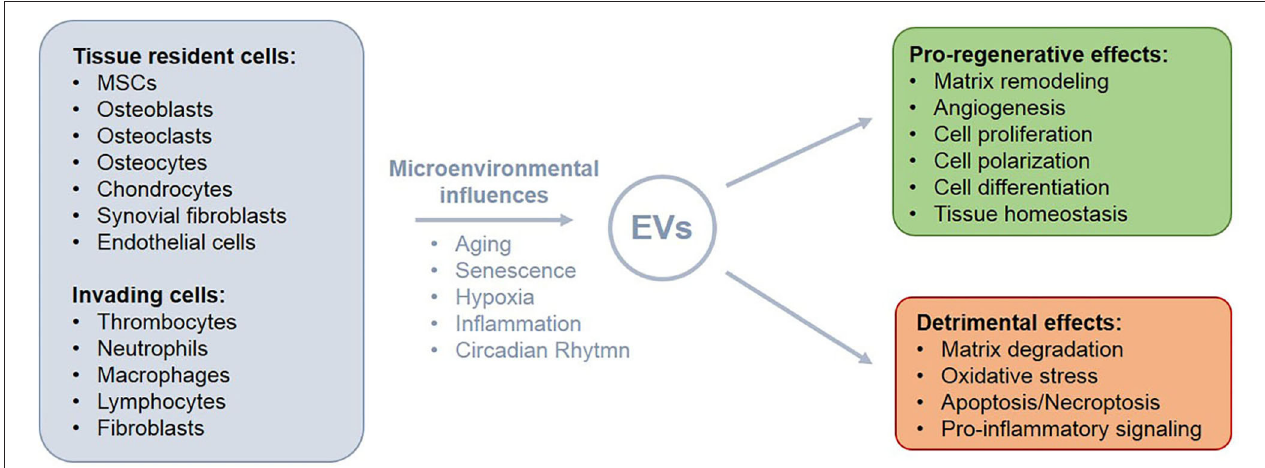
FIGURE 4 | The role of EVs in musculoskeletal diseases—from pro-regenerative to detrimental effects. EVs are an important component of cell communication in musculoskeletal tissues. They can be produced by tissue resident cells as well as by cells, which invade in the process of disease progression and healing. As the parental cells, also EVs and their cargo are affected by microenvironmental changes. EVs can contribute to physiological and pathophysiological processes and thus critically influence tissue homeostasis and